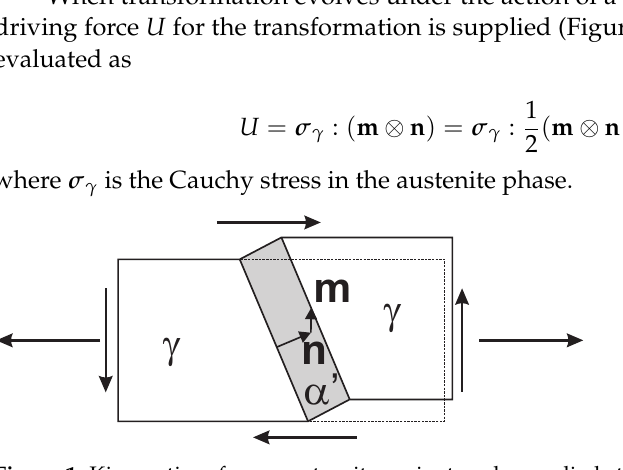
Figure 1. Kinematics of one martensite variant under applied